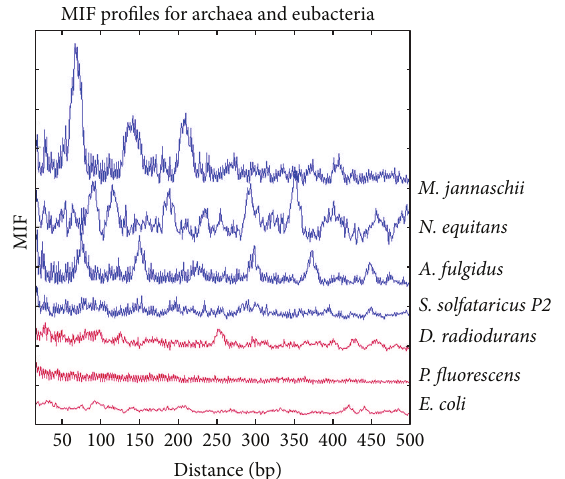
Figure 12: The MIF profiles of the decamer YYYYYRRRRR in some Archaea and Eubacterial